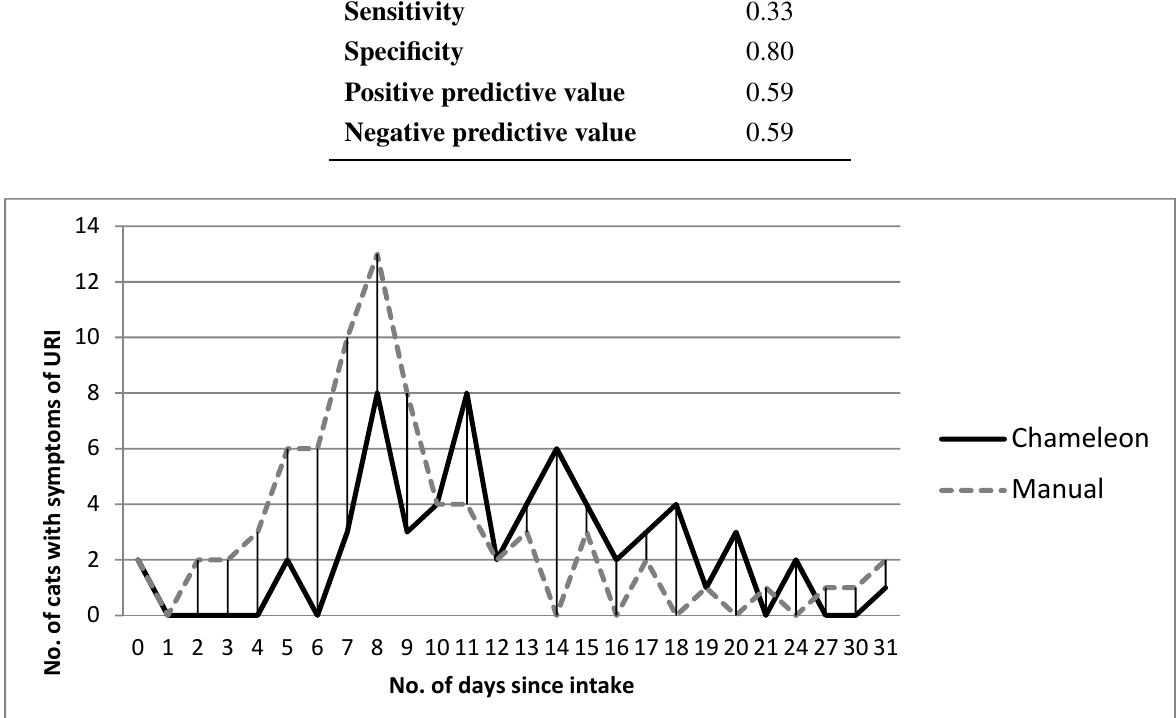
Table 4. Measurements of reliability of URI diagnosis in Chameleon reports vs. observed URI status.